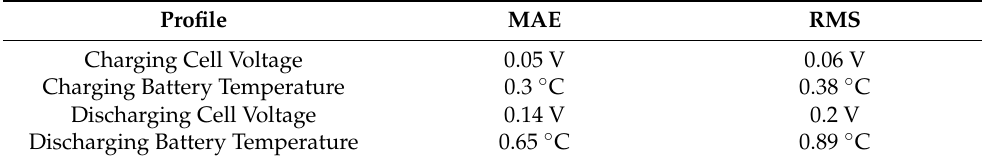
Figure 7. The cell voltage over time for the CC-CV phases for the proposed and the experimental models for the charging/discharging cycles. models for the charging/discharging cycles. Table 2. Statistics list of the fitted error of the charging and discharging Table 2. Statistics list of the fitted error of the charging and discharging profiles.